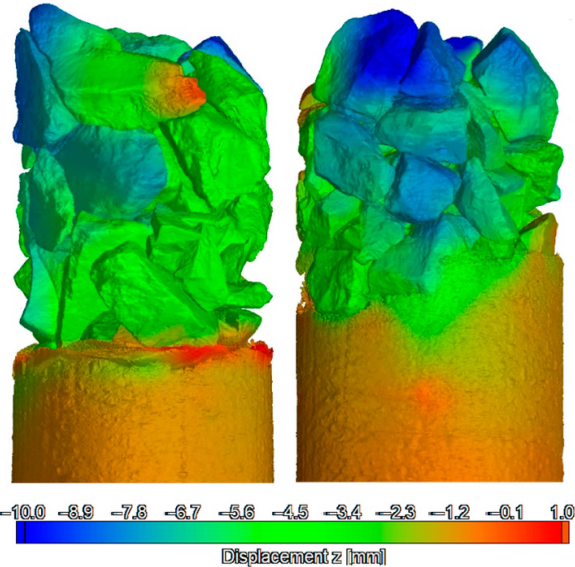
Figure 11. Displacements of the materials in the test cylinders with CC and without a CC layer (( left ) and ( right ),